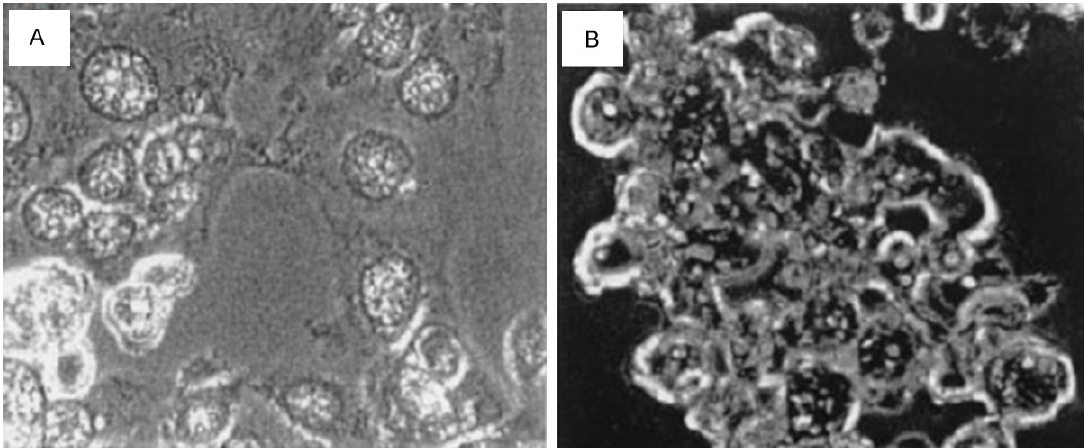
Figure 5. Cell morphology of glycitein-treated cells. A. Control SKBR-3 cells that are attached to the surface of culture plates after being treated with dimethylsulfoxide in parallel and photographed for purposes of comparison. B. After incubation with 100 mg/mL of glycitein for 4 days, SKBR-3 cells that were detached from the culture flask surface and became floated in the medium due to treatment were centrifugated, washed with phosphate buffered saline, reattached to the glass coverslip, and photographed. The bar below the photographs indicates a length for 50